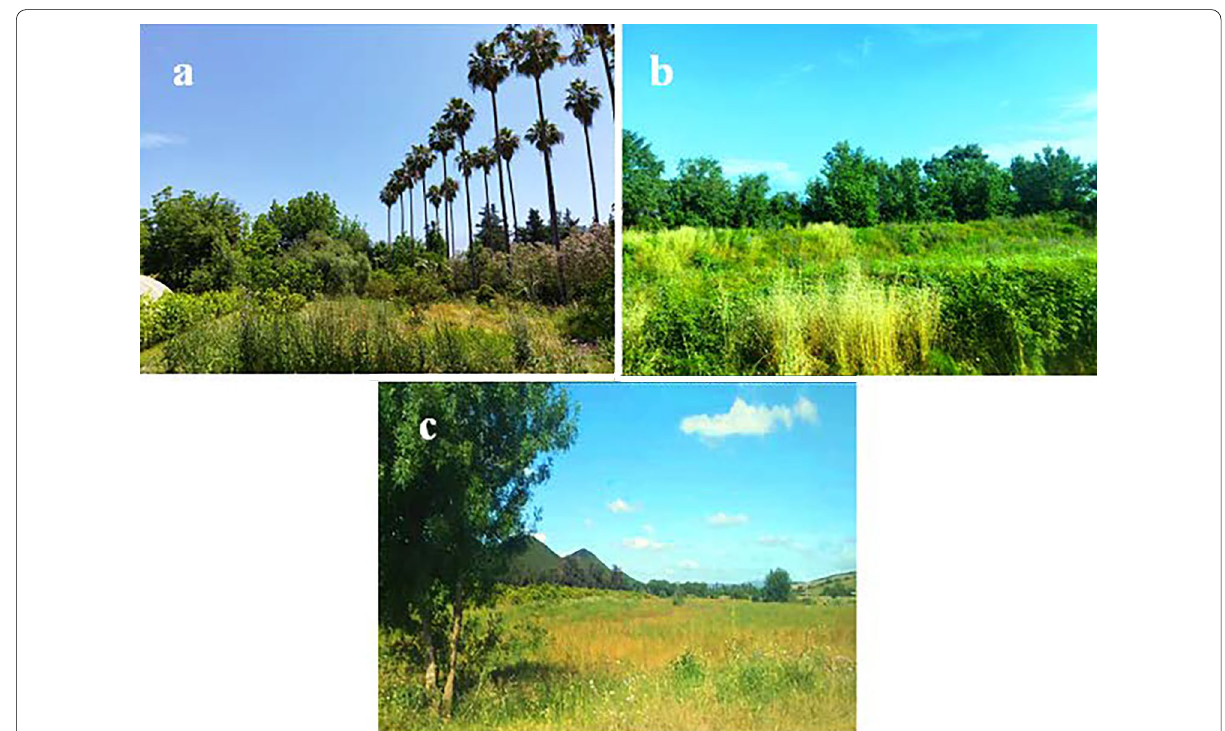
Fig. 2 Pictures taken at sampling sites in the Skikda city: El-Hadaiek ( a ); Azzaba ( b ) and Ben-Azzouz ( c